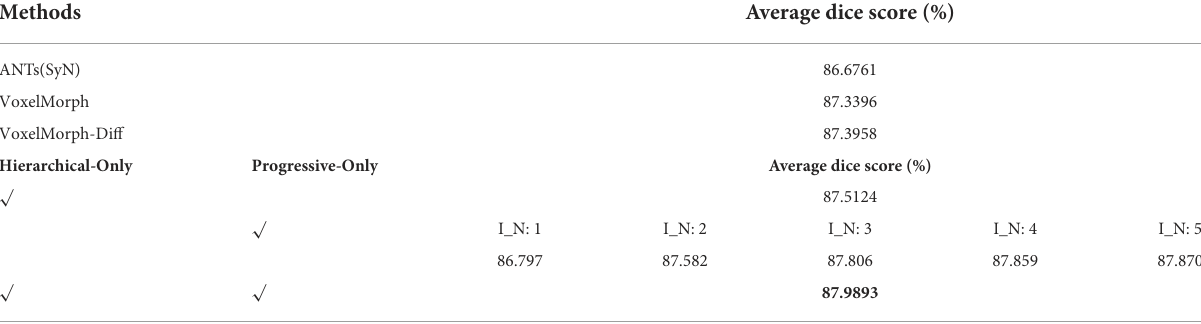
TABLE 5 The results of ablation experiments on the mouse brain dataset.